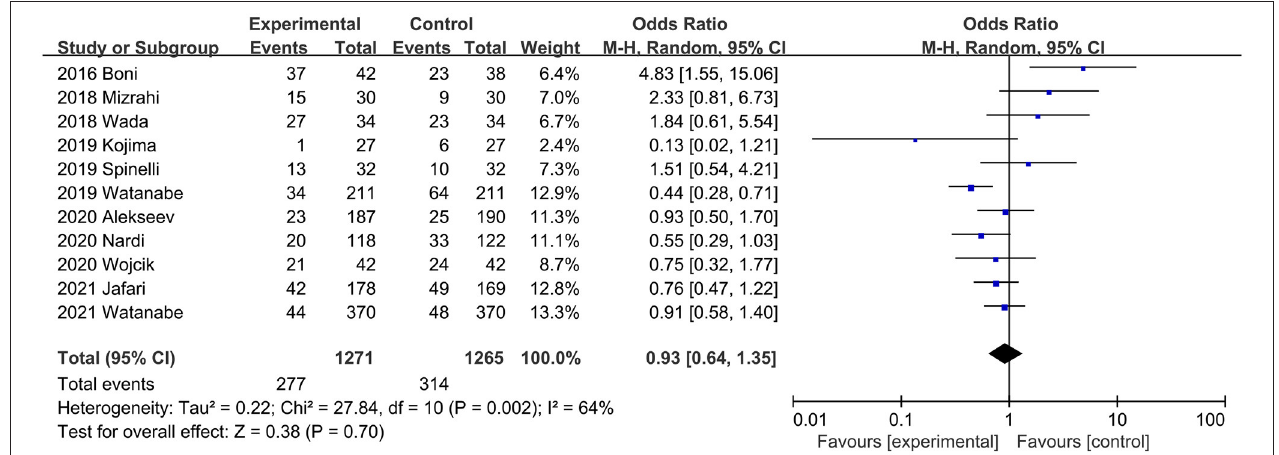
FIGURE 5 | Effect of indocyanine green on total postoperative complications rate.